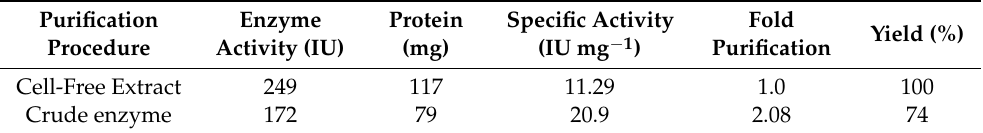
Table 4. Enzyme activity during the purification of L-asparaginase from A. arenarioides EAN603 in